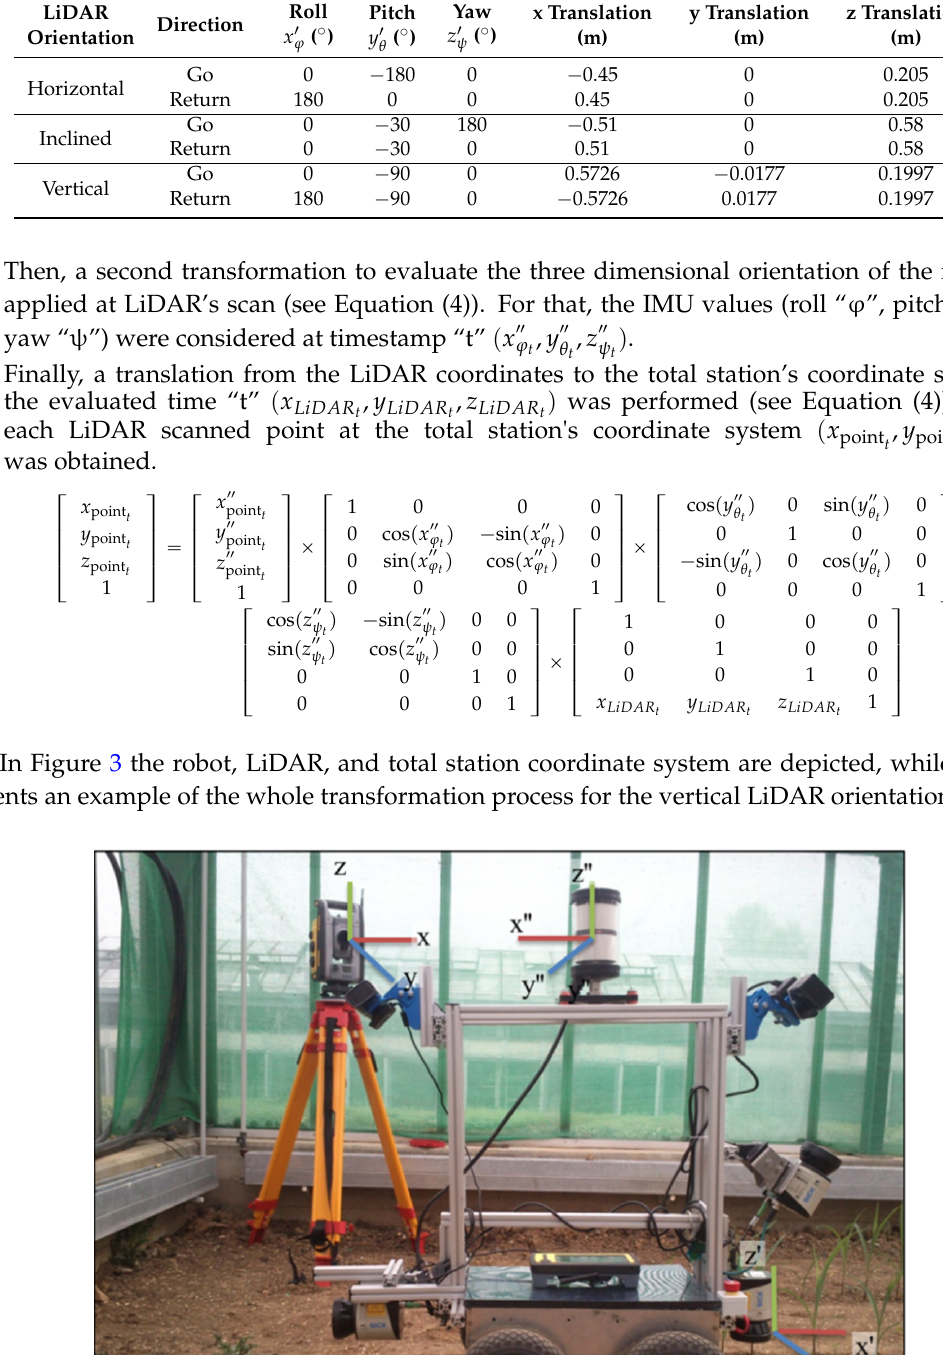
Figure 3. ( Left ) Transformation and translation process from total station to the LiDAR, and ( Right ) from the LiDAR to the scanned point. Double quoted, single quoted, and unquoted correspond to the robot’s, LiDAR’s, and total station’s coordinate system, respectively. 2.4. Point Cloud Overlapping For developing the proposed methodology ( i.e. , georeferenced overlapping of point clouds for three-dimensional maize plant reconstruction), each LiDAR orientation processed data was evaluated individually (see Figure 5). Thus, considering the goal of this research, it was possible to determine which configurations were satisfactory. Surroundings characterization by the horizontal LiDAR’s orientation was directly related to ground unevenness as its scanned points were at a larger distance compared to the other two LiDARs. In case of a leveled surface, only a small part of the plant will be detected by obtaining a single cross section for each plant at the corresponding LiDAR height. The soil will not be detected, thereby hampering the procedure of noise removal. If the robot suffers fluctuations or moves on a sloping